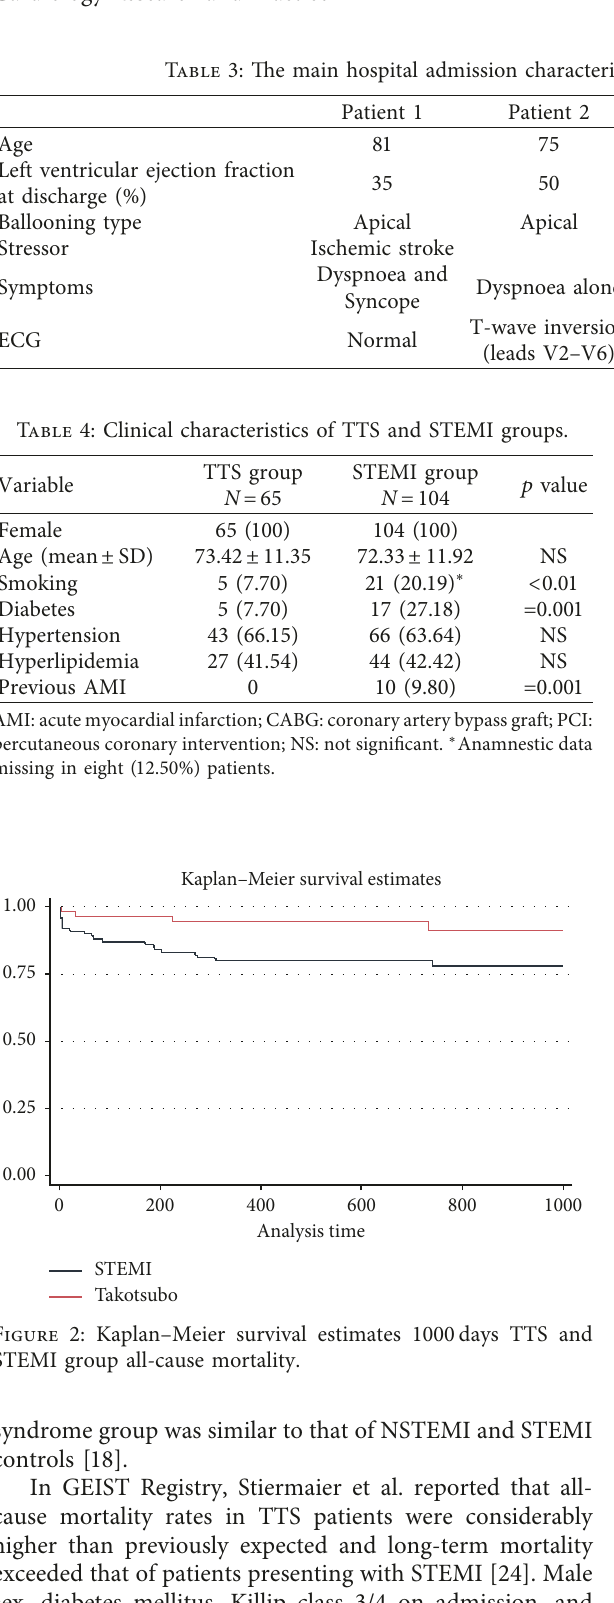
Table 3: The main hospital admission characteristics of TTS patients who died during follow-up.